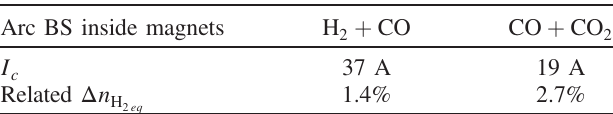
TABLE VII. Results of I the BS of the arc